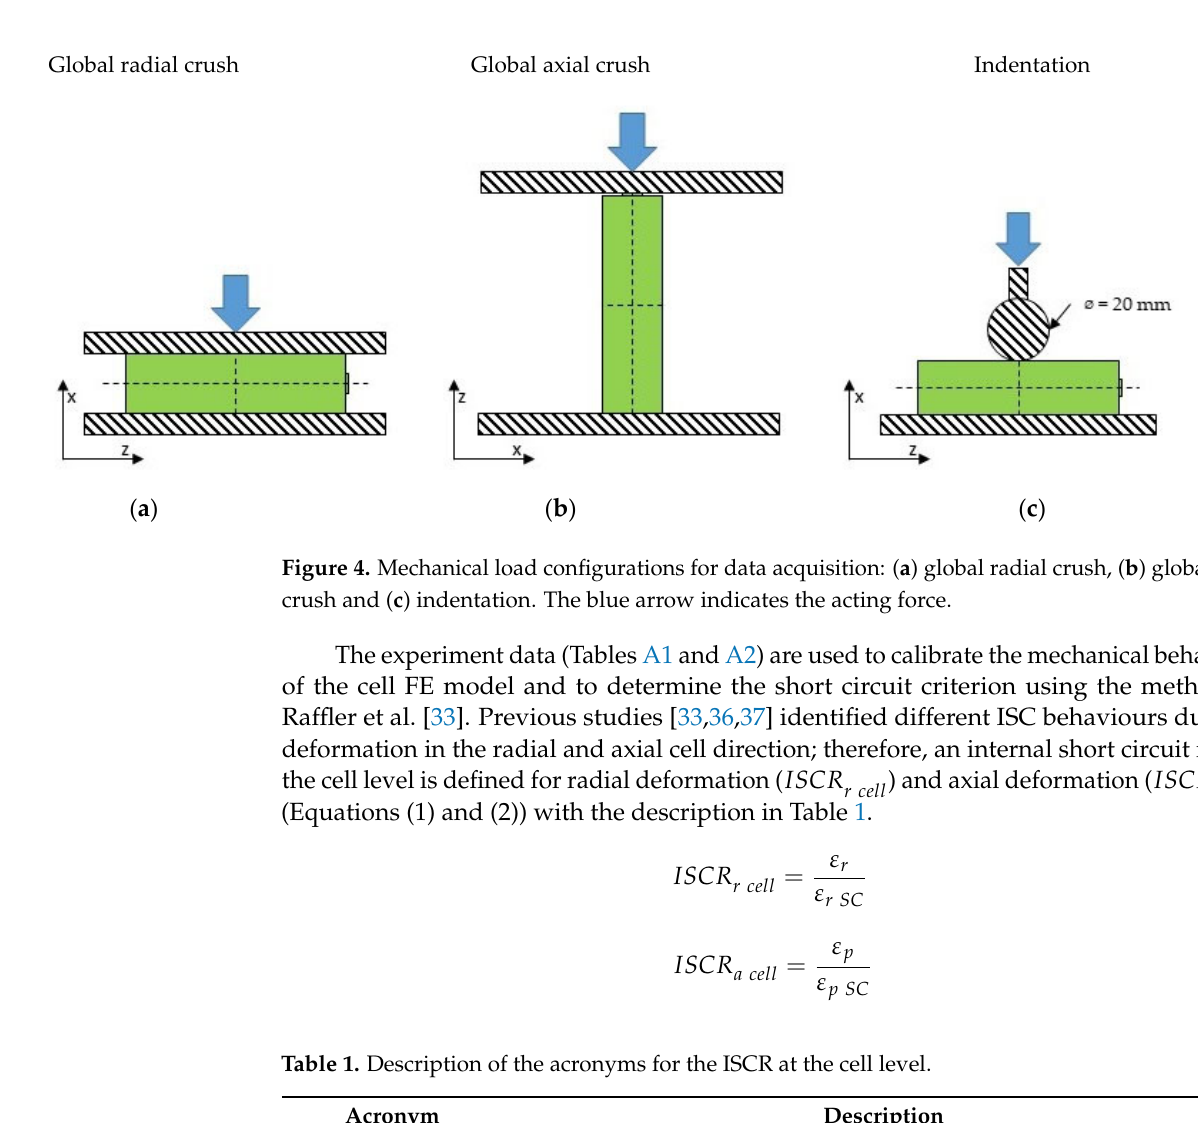
Pole cell deformation. Calculated as Pole cell deformation at ISC onset.